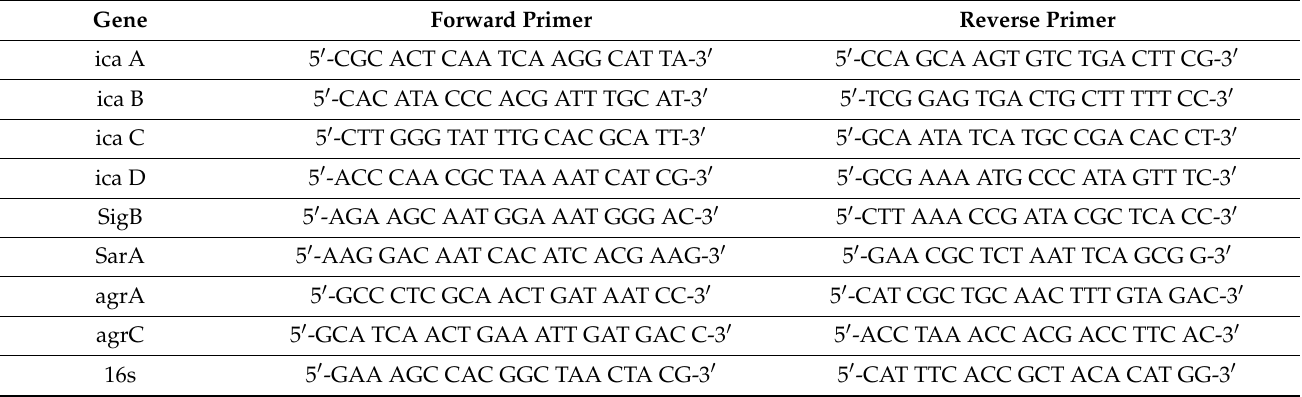
Table 1. Forward and reverse primers for Staphylococcus aureus ATCC 29213 and an isolated clinical MRSA